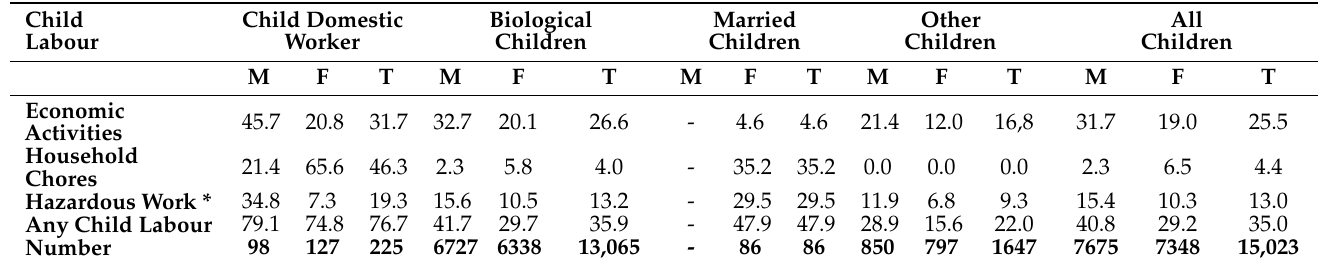
Table 3. Proportion of Child Domestic Workers, Biological children, Married children, and other children in situations of child labour ( N = 15,023,